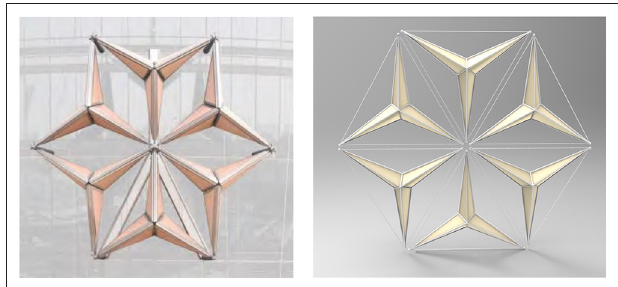
FIGURE 7 | Graphical comparison between ABS (left) and TABS (right)